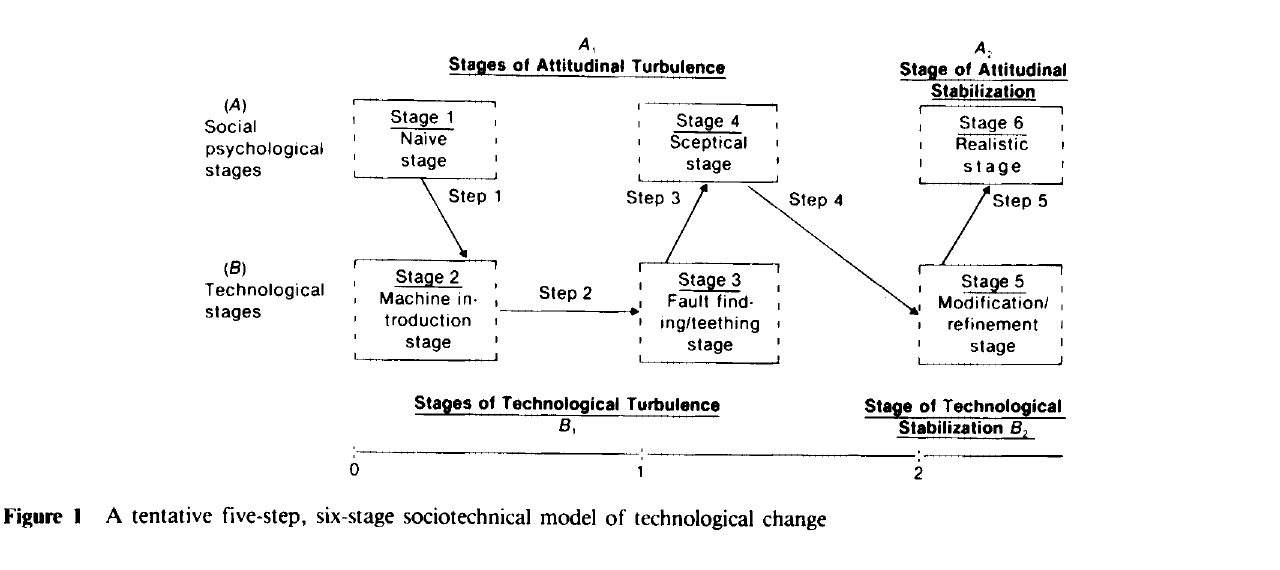
Figure I A tentative five-step, six-stage sociotechnical model of technological change